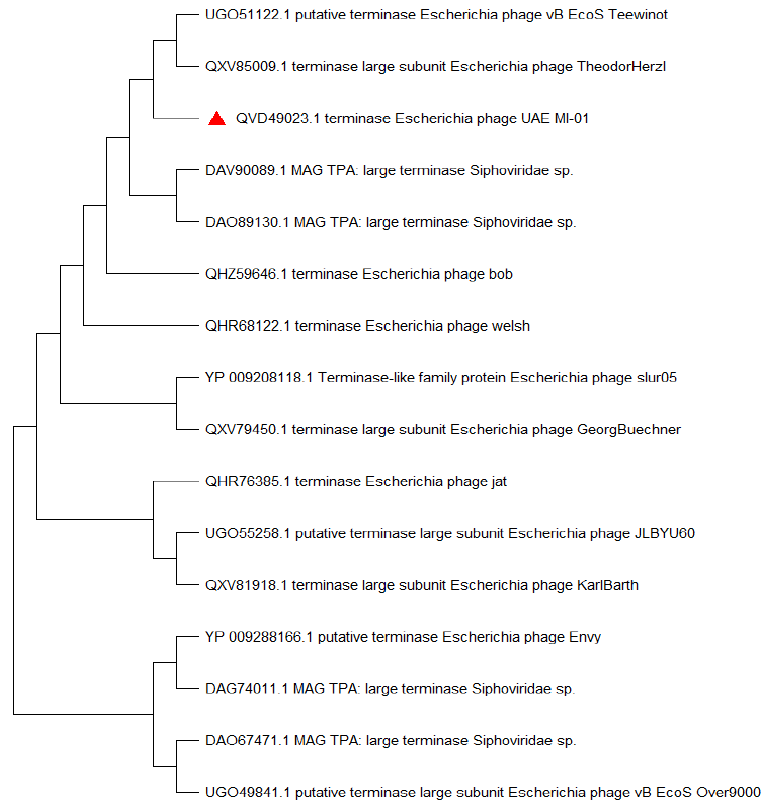
Figure 6. Phylogenetic tree showing position of the phage UAE_MI-01 phage (red triangle) based on the amino acid sequence of the terminase large subunit (TerL) of the closest 15 sequences to UAE_MI_01 TerL identified using NCBI BLASTP. Sequences were aligned using MUSCLE in MEGA 11 (https://www.megasoftware.net (accessed on 21 April 2022)) and the phylogenetic tree was generated using the neighbor joining method.